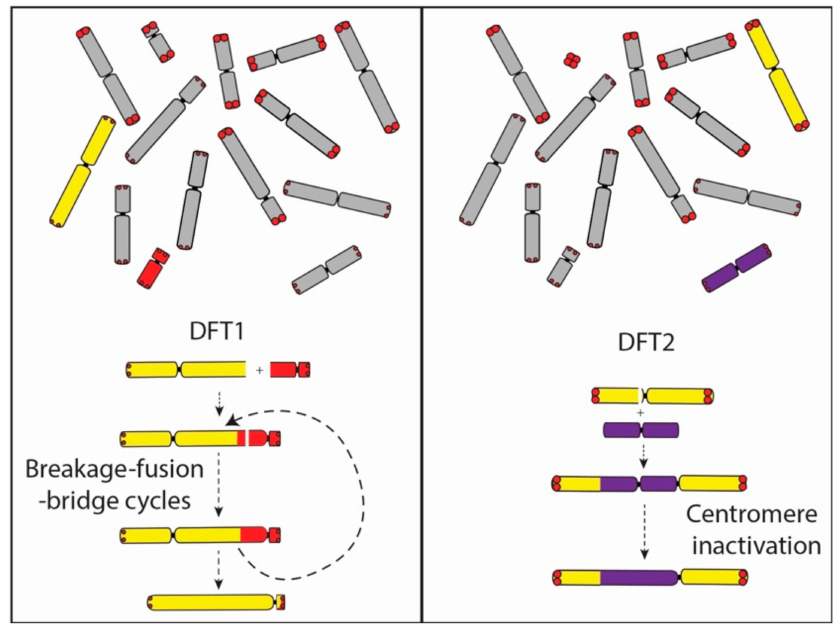
Figure 6. Dicentric chromosome formation in DFT1 and DFT2. In DFT1, the dicentric chromosome formed from the fusion of chromosome 1 and X is proposed to have led to a series of breakage–fusion–bridge cycles until a single active centromere remained. The translocation of chromosome 6 onto chromosome 1 in DFT2 was followed by the inactivation of the chromosome 6 centromere. Abbreviations: DFT1, devil facial tumour 1. DFT2, devil facial tumour